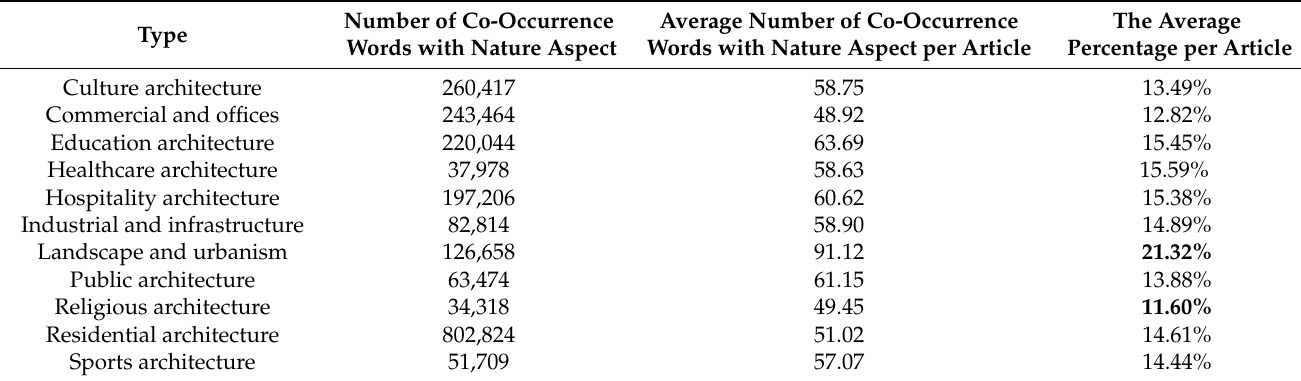
Table 2. The results of word co-occurrence.